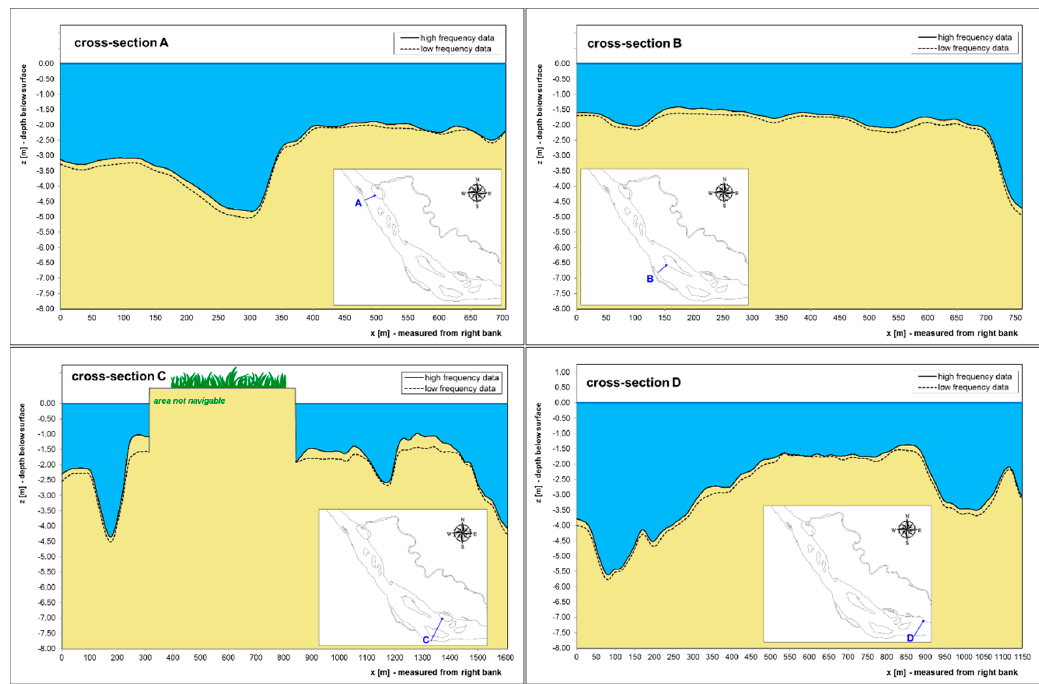
Figure 9. A selection of cross-sections of investigated area (high and low frequency data).